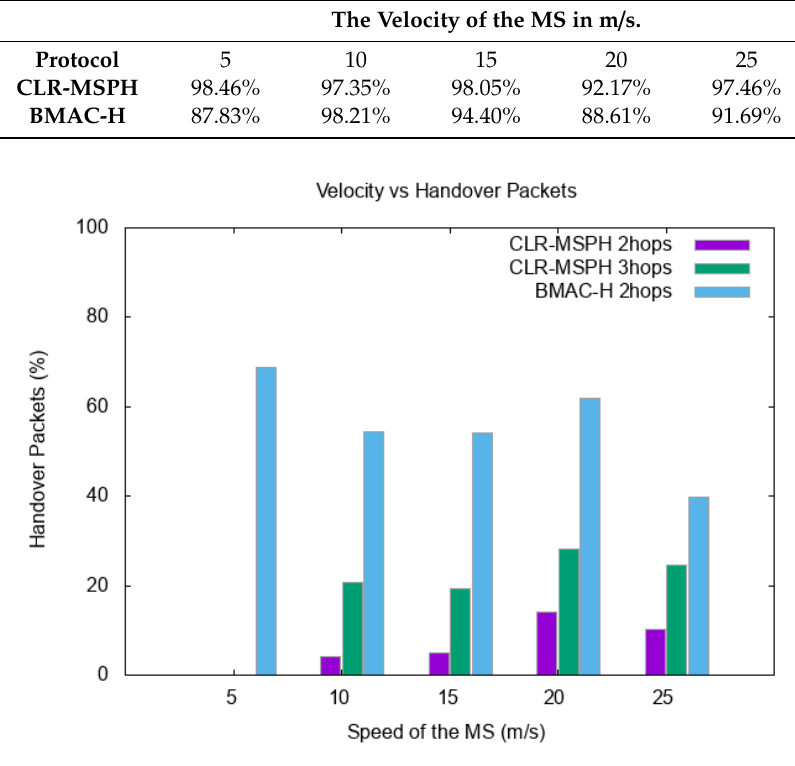
Figure 9. Handover packets in each protocol with varying the speed of MS. Table 3. Handover packets in each protocol varying the speed of MS. The velocity of the MS in m/s.